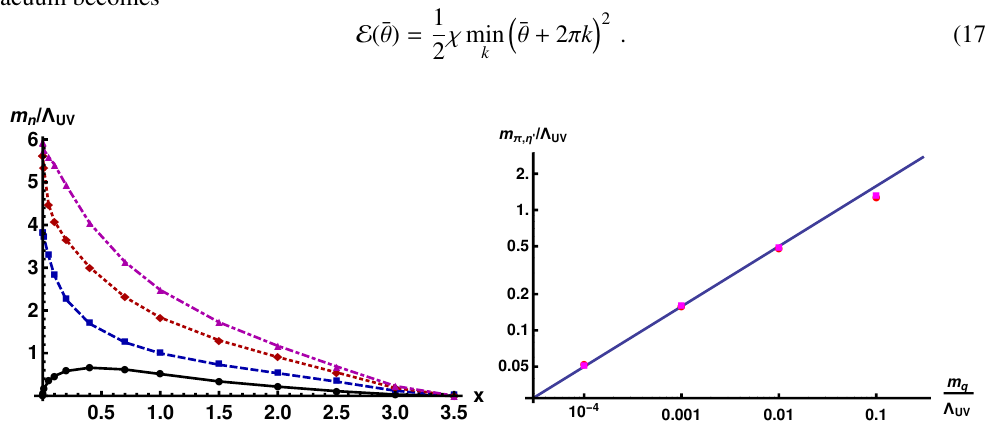
Figure 3. Left: masses of the lowest four singlet pseudoscalar states as a function of x . Right: the dependence of the mass of the η (cid:48) (red circles) and the pion mass (magenta squares) on m q at x = 0 . 0001. The blue line is a fit to the Gell-Mann-Oakes-Renner